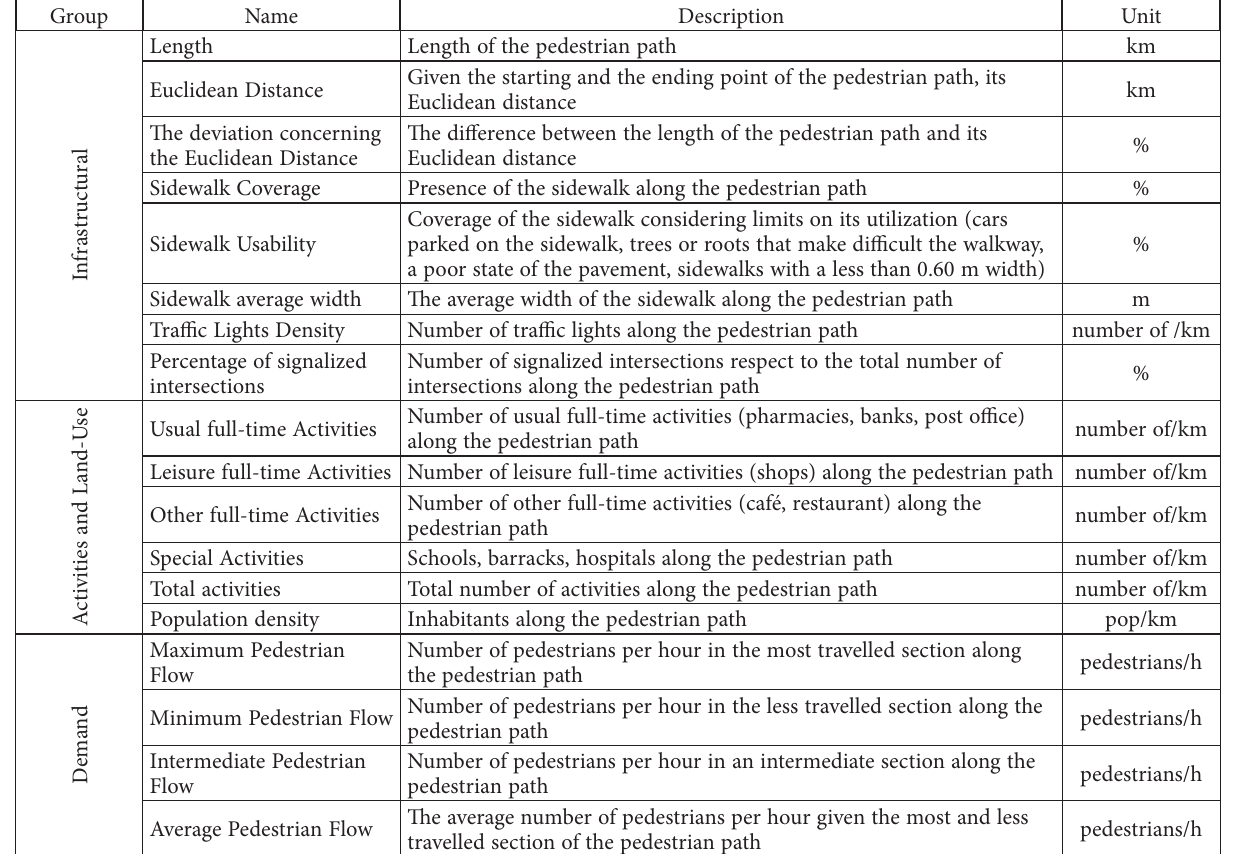
Table 1. Data collected in the field describing pedestrian paths characteristics